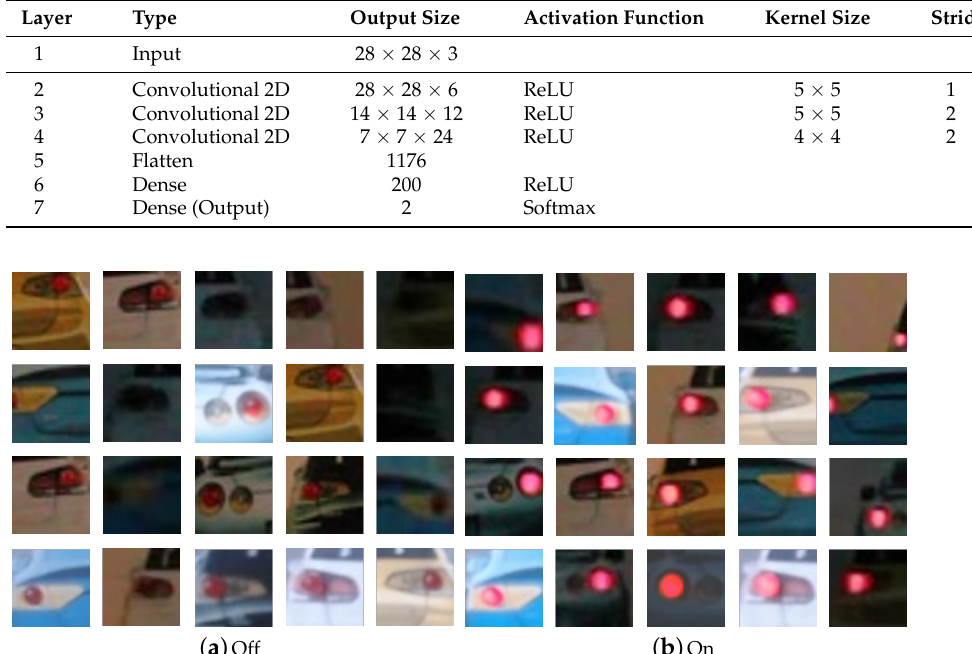
Table 1. Summary of neural network layers for taillight state recognition.